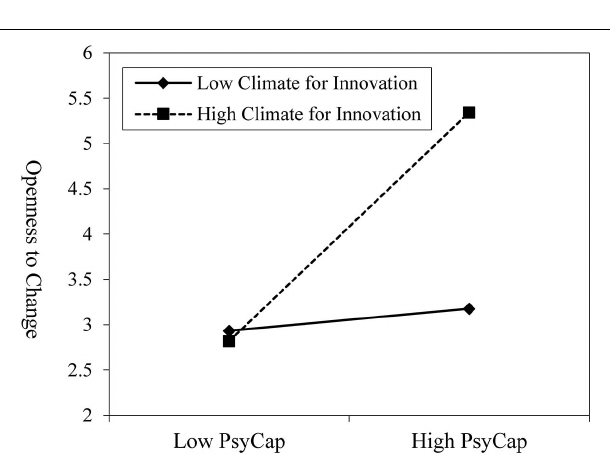
FIGURE 3 | Moderating effect of climate for innovation on the relationship between PsyCap and openness to change.